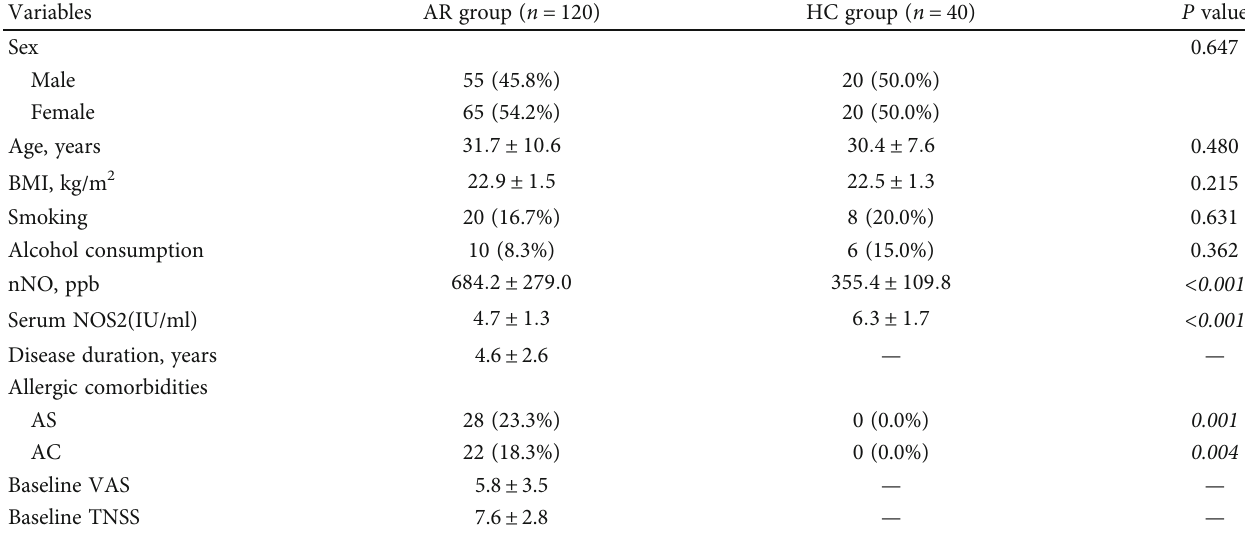
Table 1: Demographics and clinical characteristics of patients between two groups.